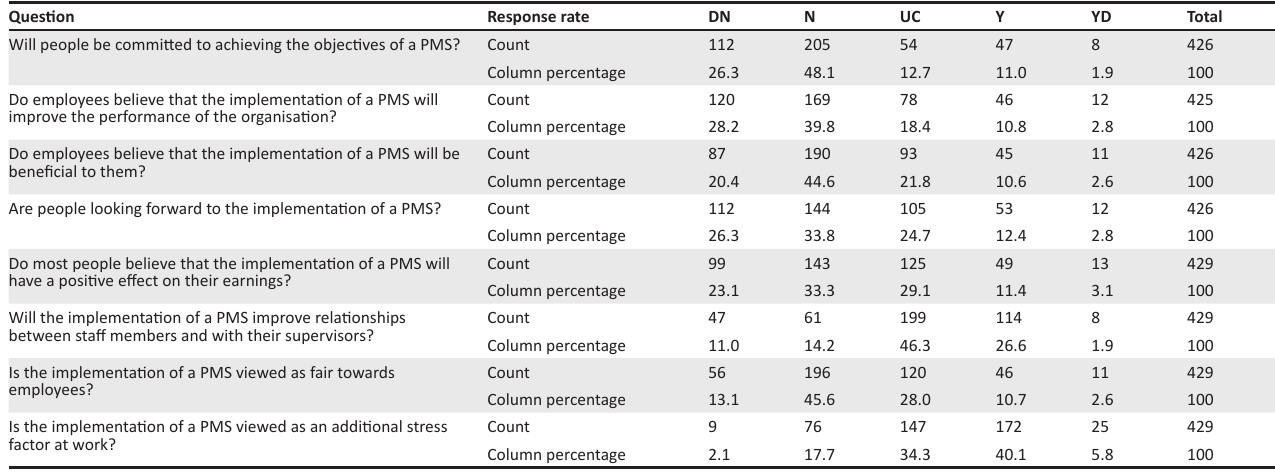
TABLE 10: Attitudes and feelings about introducing a performance management system. Question